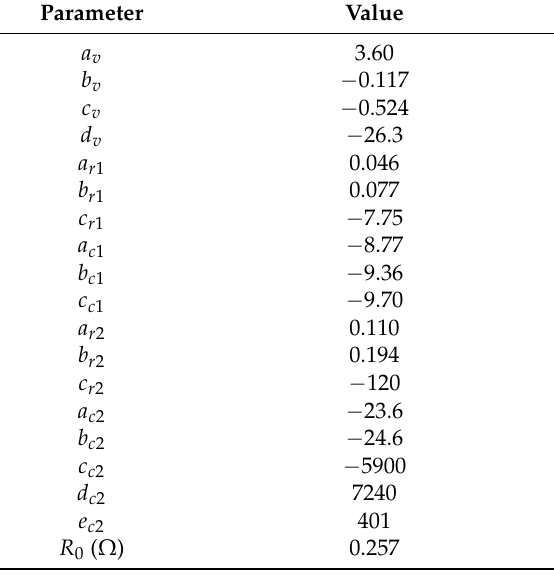
Table A2. Experimental constants.